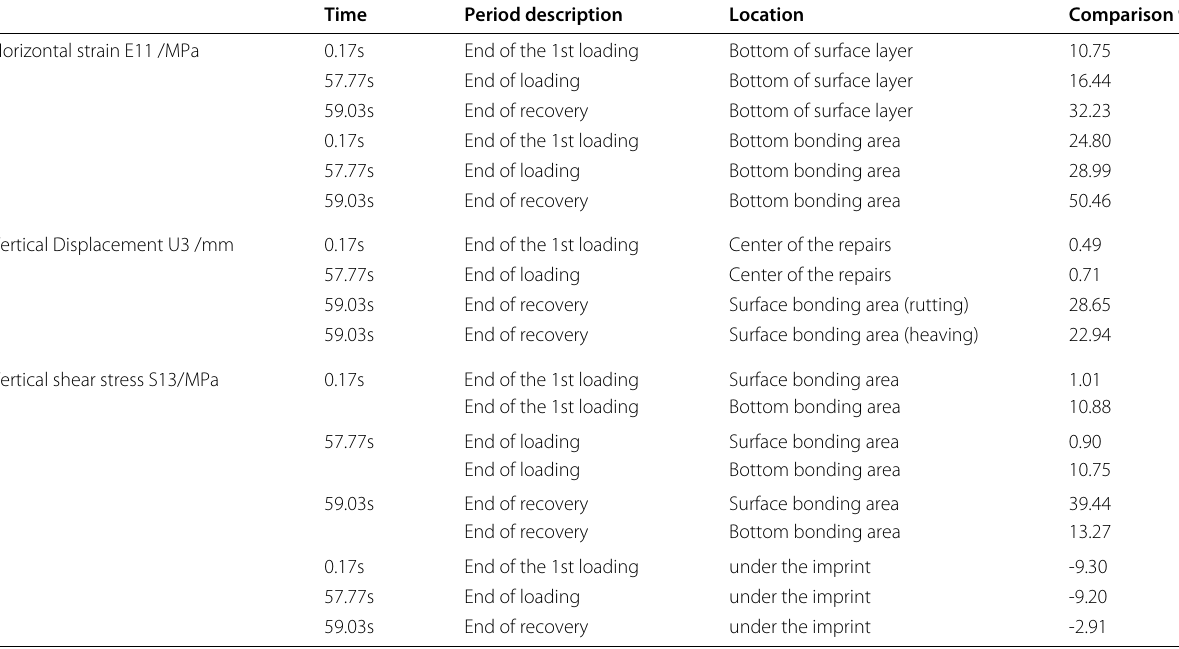
Table 3 Pavement effect of small size repairs for circle and rectangle at different time and